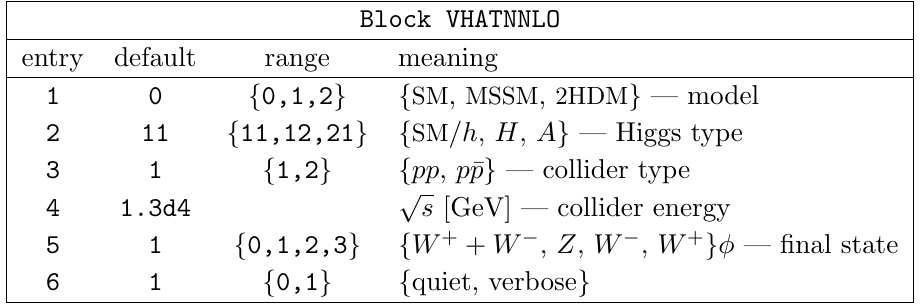
Table 2 . Basic run parameters of